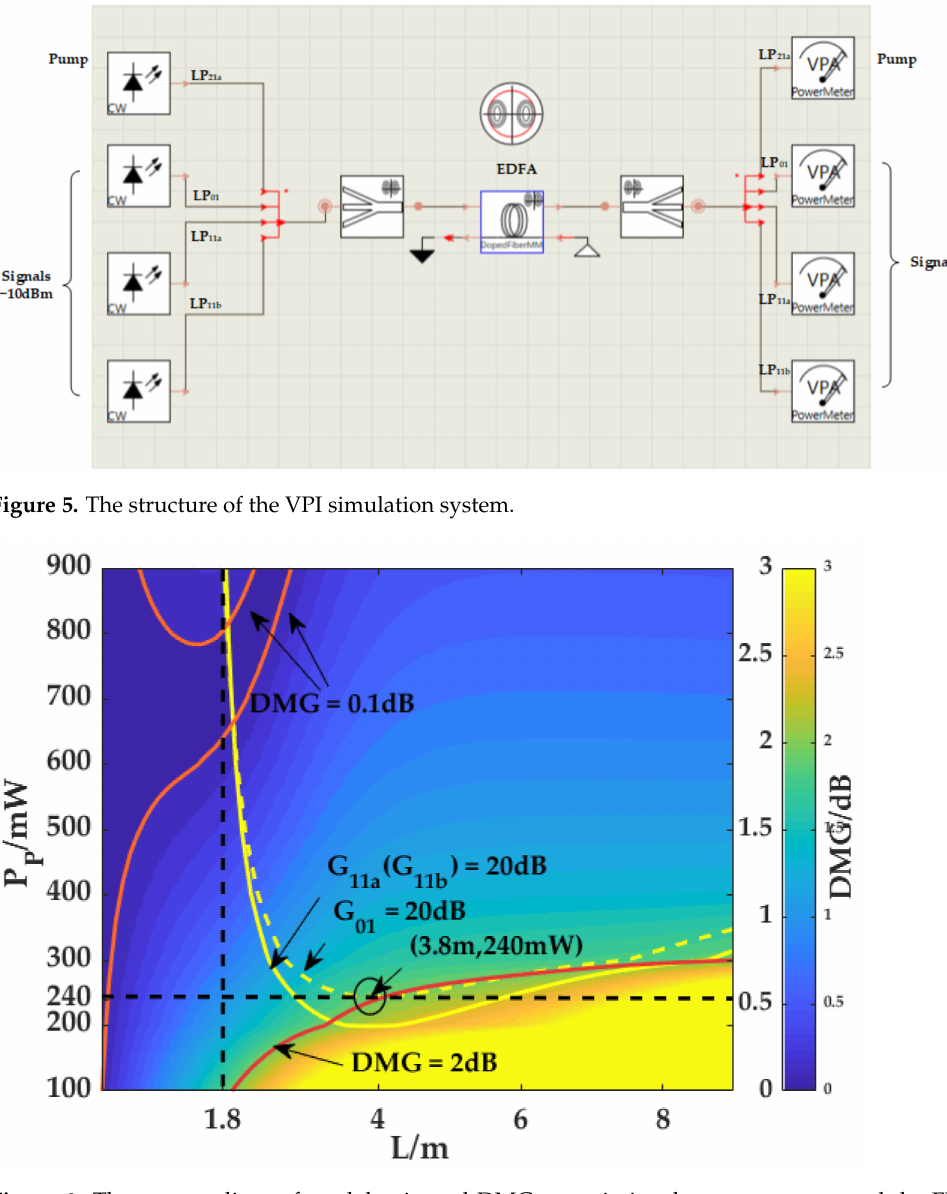
Figure 6. The contour lines of modal gain and DMG to optimize the pump power and the FM- EDF’s